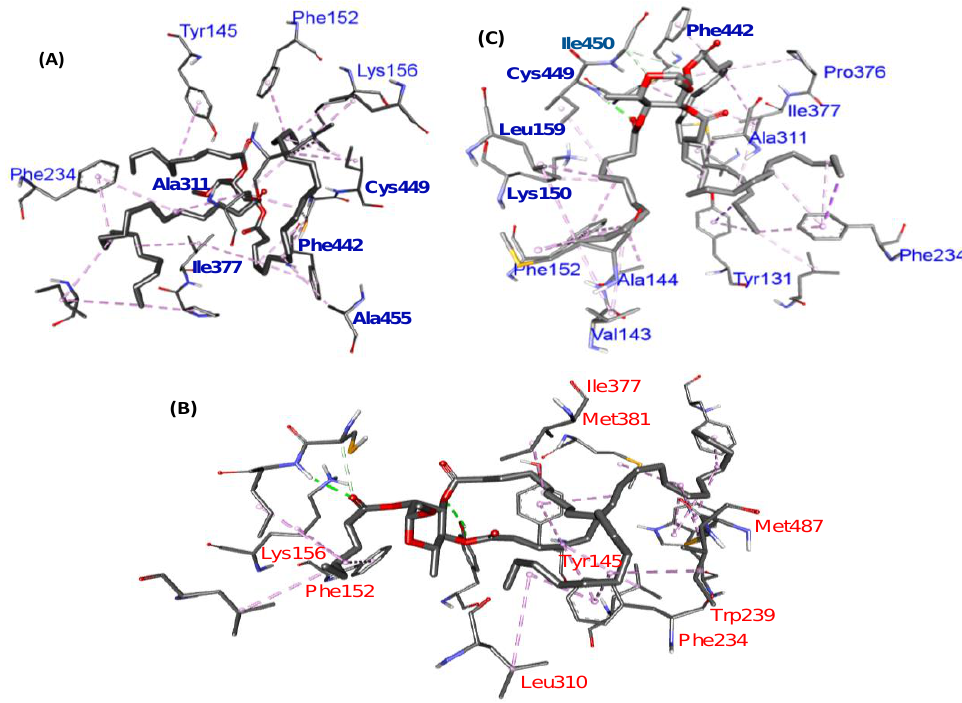
Figure 5. 3D Interaction of ( A ) 10 , ( B ) 9 , and ( C ) 7 with amino acid residues of 4LD6.